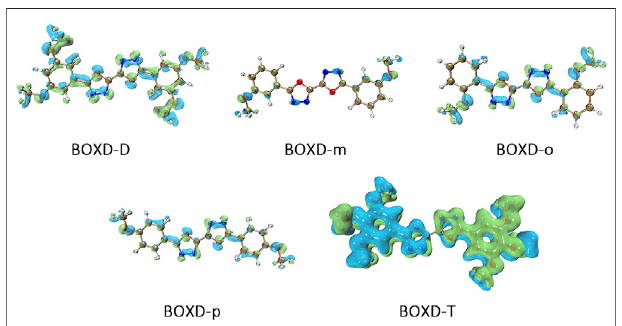
FIGURE 9 | Electron density differences of neutral molecule and cation.